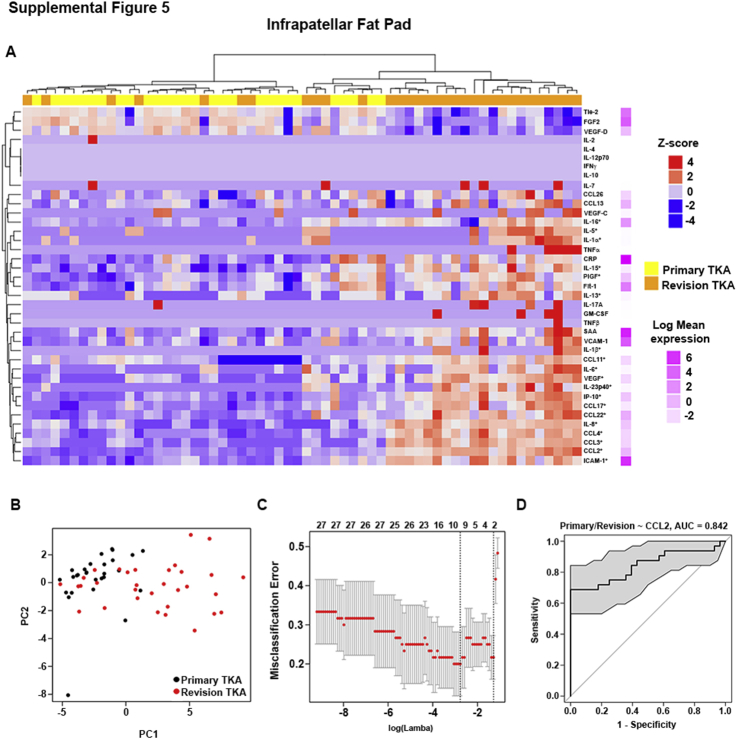
The inflammatory signature in infrapatellar fat pad does not effectively stratify patients into those undergoing revision total knee arthroplasty (TKA) from those undergoing primary TKA. A: Heat map of log-transformed protein intensity in infrapatellar fat pad isolated from patients undergoing primary or revision TKA clustered using the DE markers with the highest fold change. Asterisks indicate markers that were used for clustering analysis/stratification. B: Principal component analysis plot of all patients using all markers. C: Classification error as function of the number of markers included, cross validated using glmnet package. Dotted lines mark two important values of the regularization parameter λ, which controls the number of markers included. On the left is the value of λ that gives the minimum mean cross-validated error. On the right is the value that gives the most regularized model, such that error is within one SEM of the minimum. D: Receiver operating characteristic curve for classification with CCL2 alone [area under the curve (AUC), 0.842; 95% CI, 0.74–0.95]. CRP, C-reactive protein; FGF, fibroblast growth factor; Flt, Fms-like tyrosine kinase 1; GM-CSF, granulocyte-macrophage colony-stimulating factor; ICAM, intercellular adhesion molecule; IFN, interferon; IP-10, interferon gamma-induced protein 10; PIGF, placental growth factor; SAA, serum amyloid A; Tie, tyrosine kinase; TNF, tumor necrosis factor; VCAM, vascular cell adhesion molecule; VEGF, vascular endothelial growth factor.